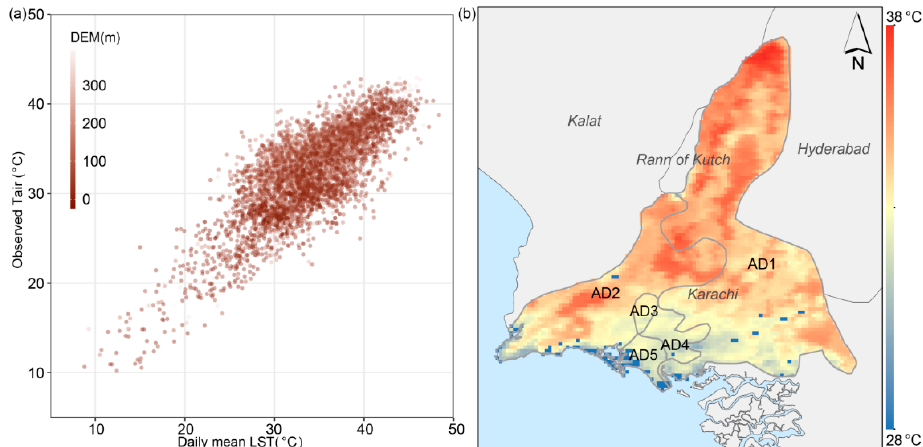
Figure 3. ( a ) Scatter plots between the daily mean land surface temperature (LST) and observed daily mean temperature (T air , it noted that this correlation was stable where the elevation (DEM) is below 500 m.; ( b ) Predicted T air from the LST of each administrative district (AD) of Karachi, including Malir (AD1), Karachi West (AD2), Karachi Central (AD3), Karachi East (AD4) and Karachi South (AD5).